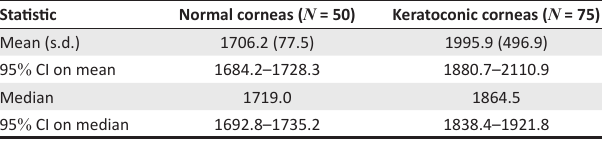
TABLE 3: Descriptive statistics are given for 50 normal and 75 keratoconic sag measurements.